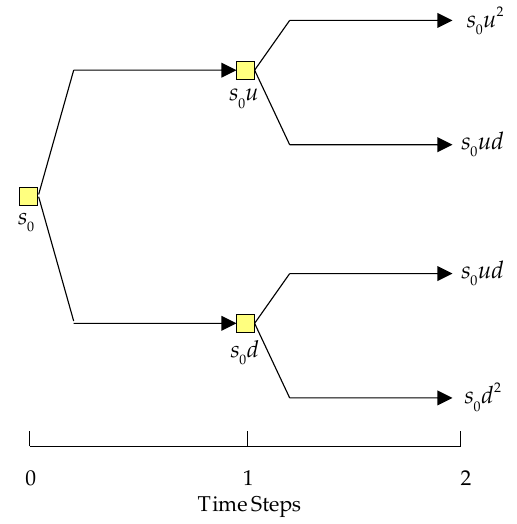
Figure 2. Binomial Lattice. Source: Adapted from Kodukula and Papudesu [99].